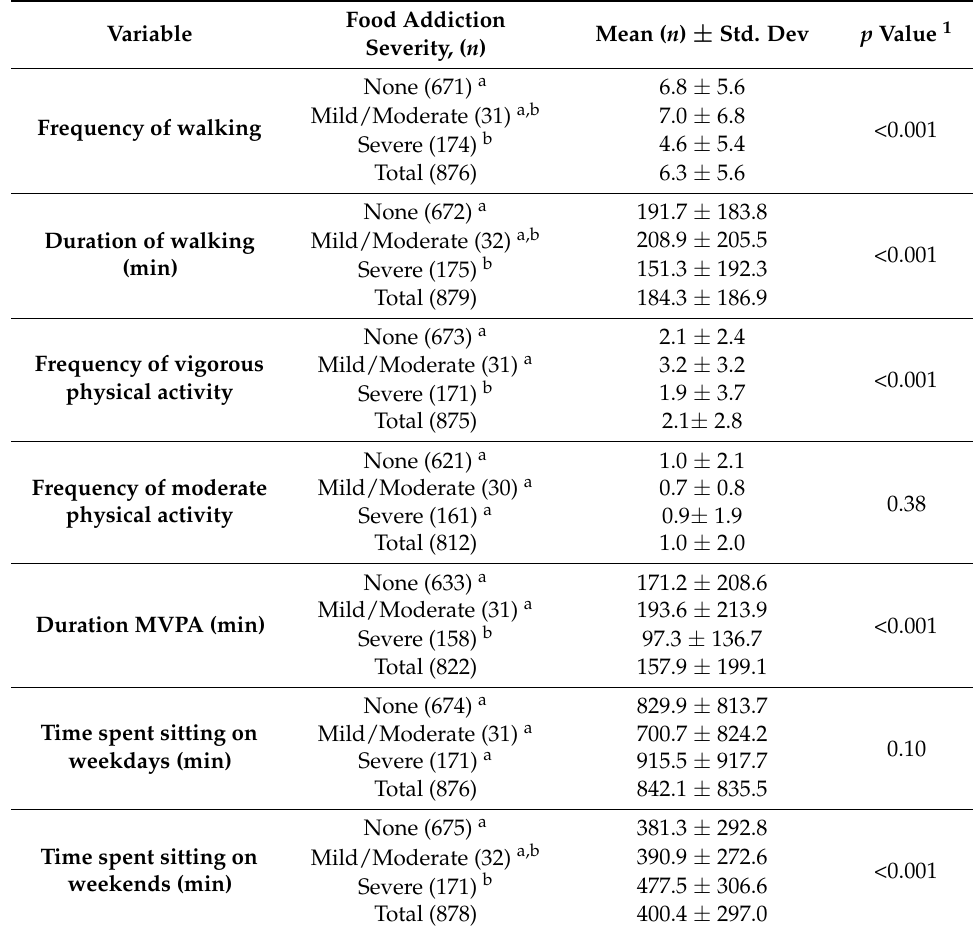
Table 2. Physical Activity variables by Food Addiction